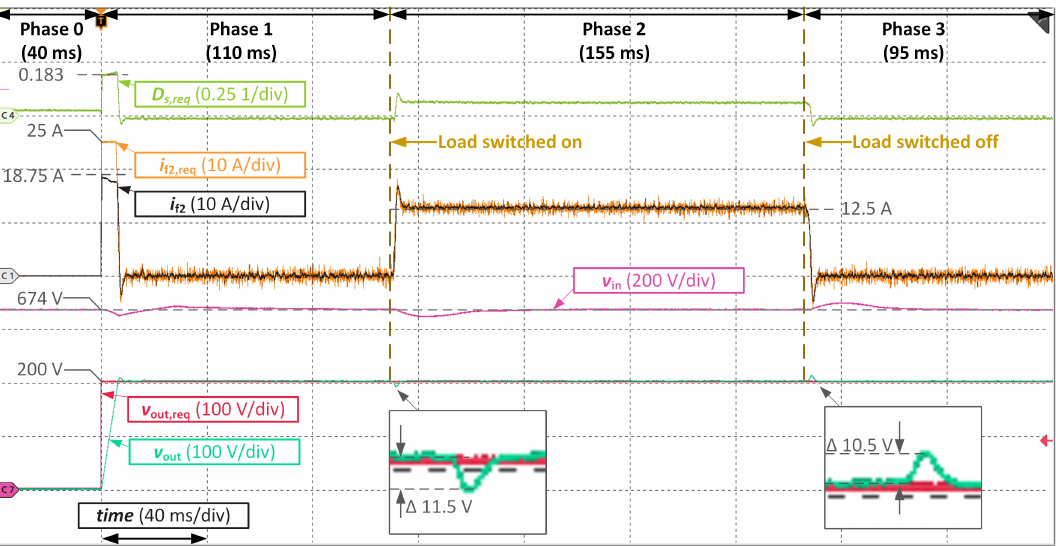
Figure 16. Experimental results for controllers tuned according to parameters (31)–(33) and (48), (49): reference voltage value for the active rectifier v in,ref = 670 V, reference output voltage value for the DAB converter v out,ref = 200 V, additional current limitation I spec = 25 A, resistive load R = 16 Ω